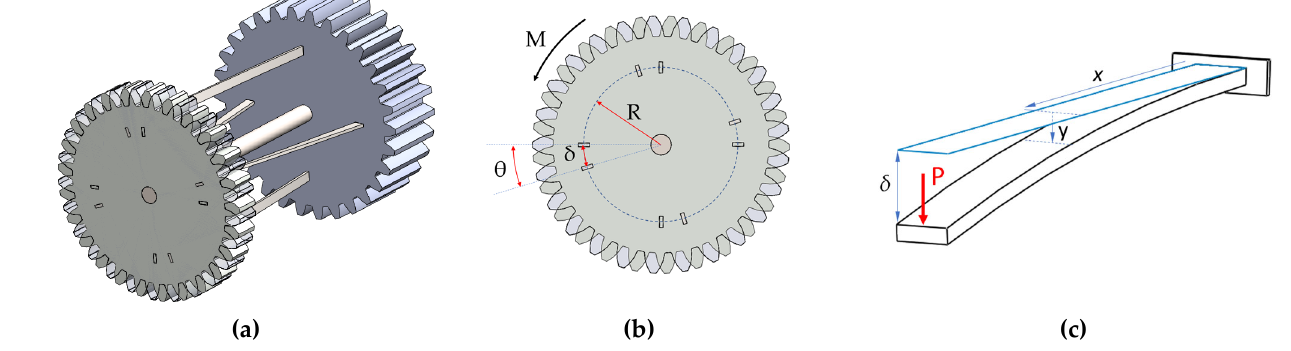
Figure 2. Torsion and bending model of elastic beams in the adjustable clutch mechanism. ( a ) Elastic deformation of the clutch, ( b ) torsion and deflection of the active end of the beams. (Torsion an ‐ gle, 𝜃 (cid:3404) 𝛿 𝑅 ⁄ ), and ( c ) bending model: deflection of the active end of the beams.